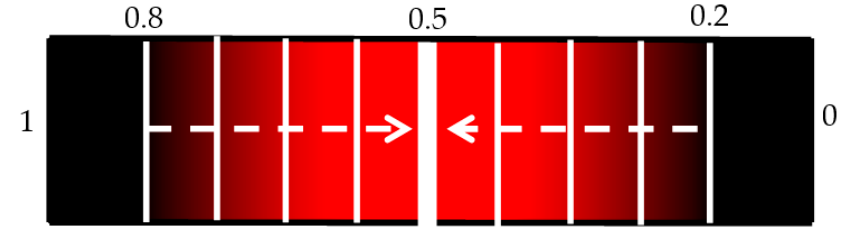
Figure 8. Changing threshold level. Starting at the smallest thresholds (0.2 and 0.8), the thresholds are increased until they meet at the middle.